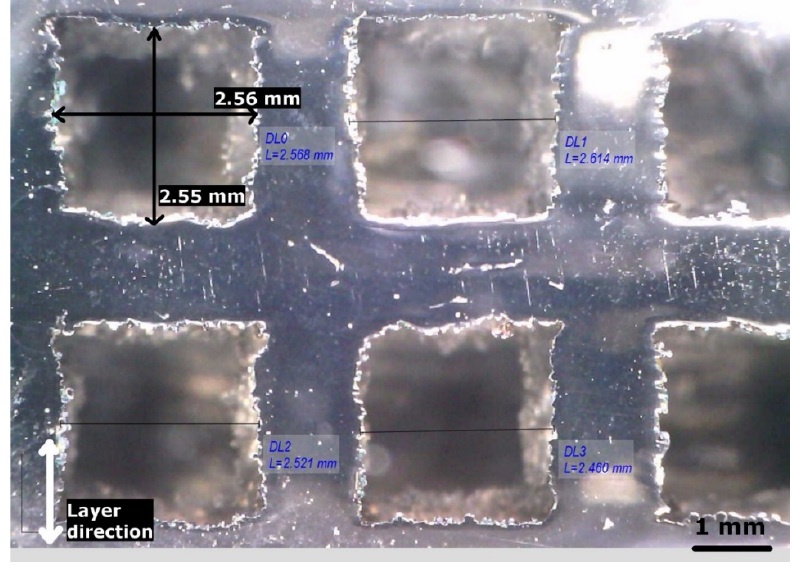
Figure 7. Macro image of 1.5 mm horizontal struts produced using standard scan strategy (cross-section along XY direction).